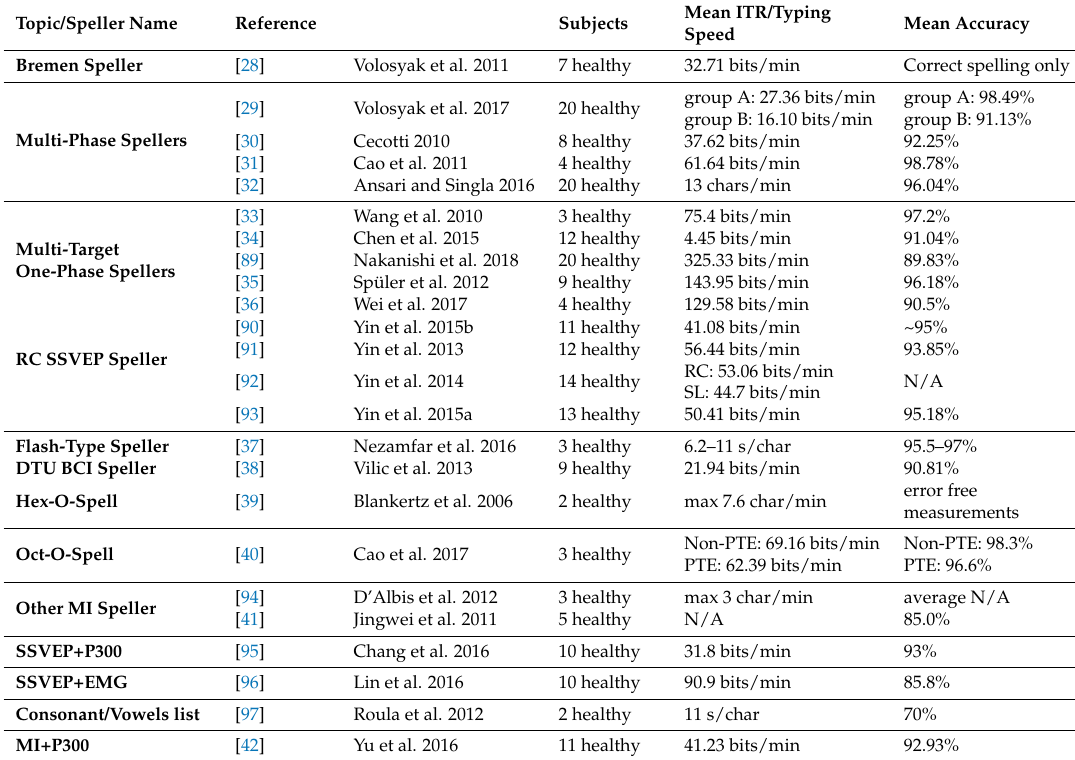
Table 4. Summary of the spellers discussed in this review which are based on SSVEP, MI, and Hybrid